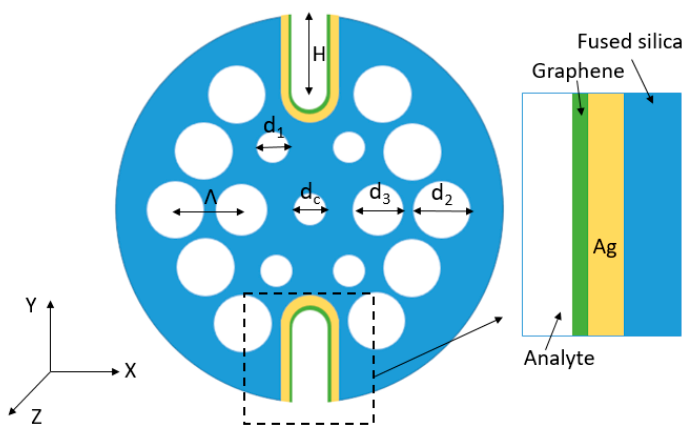
Figure 1. Schematic of the designed Ag-Graphene coated PCF-SPR sensor.